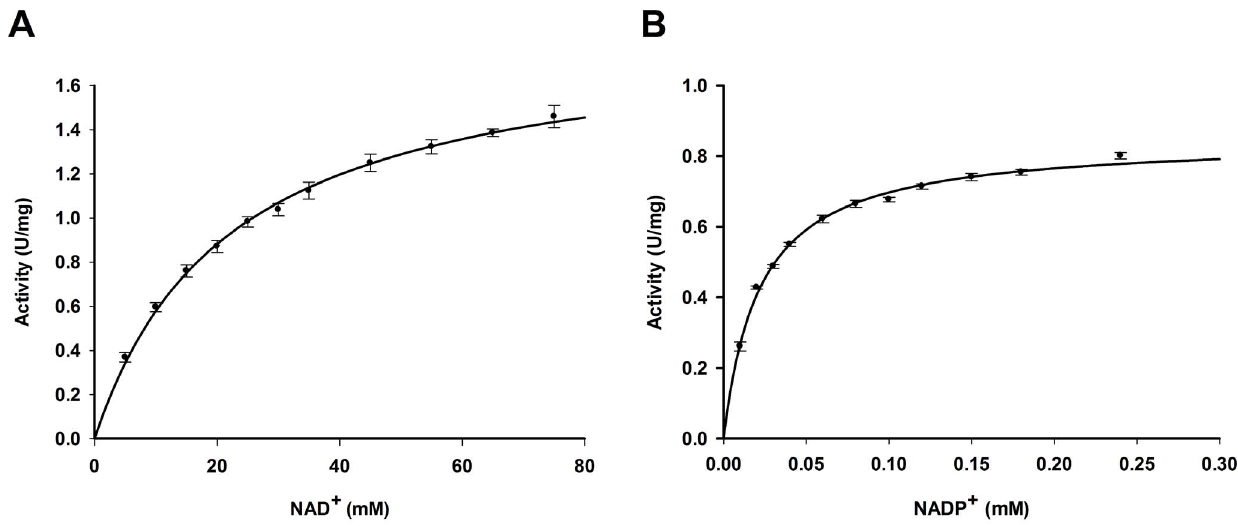
Figure 5. Michaelis-Menten kinetics of refolded Ta AlDH with cofactors A) NAD + and B) NADP + . Reaction rates were determined in 100 mM HEPES pH 6.2 at 50 u C with 5 mM D -glyceraldehyde and various concentrations of NAD + or NADP + , respectively.